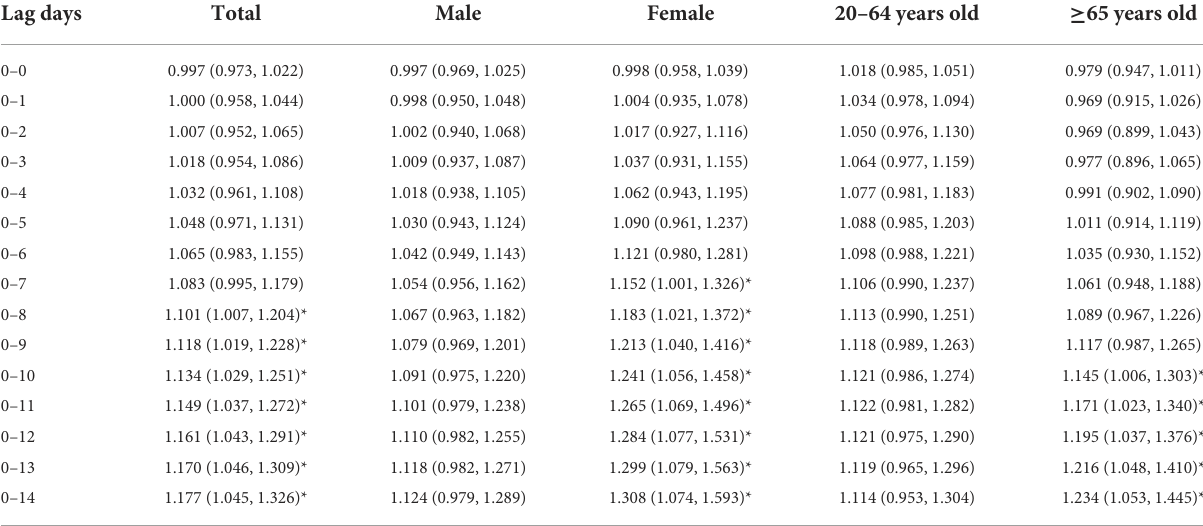
TABLE 2 Cumulative relative risks (95% CI) of AMI hospitalizations associated with extreme precipitation among the total population and different subgroups in Beijing, China from 2013 to